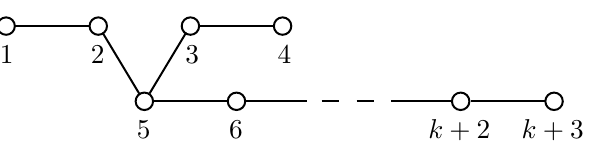
Figure 2 . Dynkin diagram of the Kac-Moody algebra of rank k +3 corresponding to the Borcherds superalgebra with the Dynkin diagram in (cid:12)gure 1 by the ‘Borcherds-Kac-Moody correspondence’. The number of nodes in the lower line is k (cid:0) 1, forming an A k (cid:0) 1 subdiagram. For k = 3, this Kac-Moody algebra is the exceptional Lie algebra E 6 , for k = 4 its a(cid:14)ne extension E 6+ , and for k = 5 its hyperbolic extension E 6++